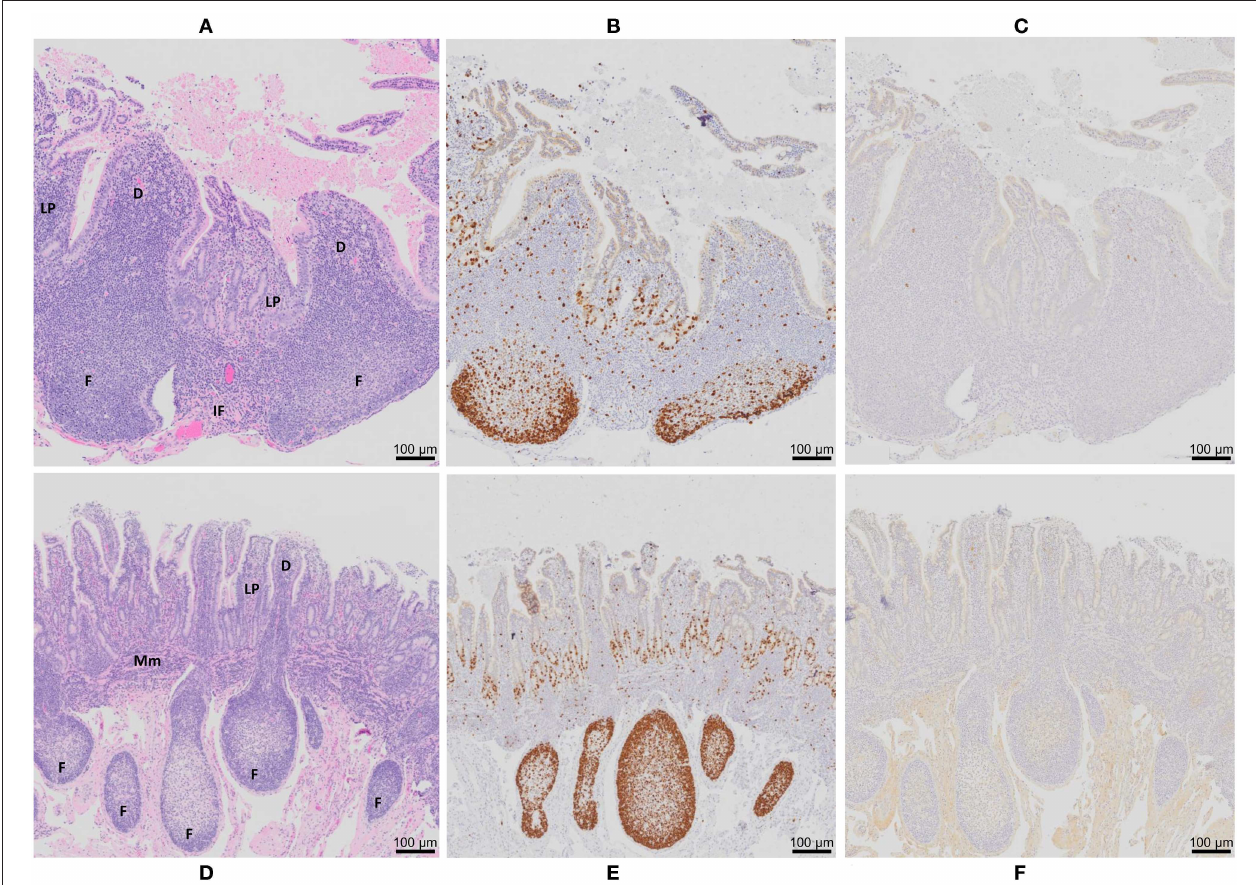
FIGURE 2 | Peyer’s patch architecture and histochemical staining of intestinal segments from control animals 12 months post-surgical isolation. Serial sections of (A–C) a DPP and (D–F) a CPP were stained with (A,D) hematoxylin and eosin, (B,E) Ki-67 (brown color), and (C,F) MAP antigen (brown color). D, dome region; F, lymphoid follicle; IF, interfollicular region; LP, lamina propria; Mm, muscularis mucosae. Magnification is